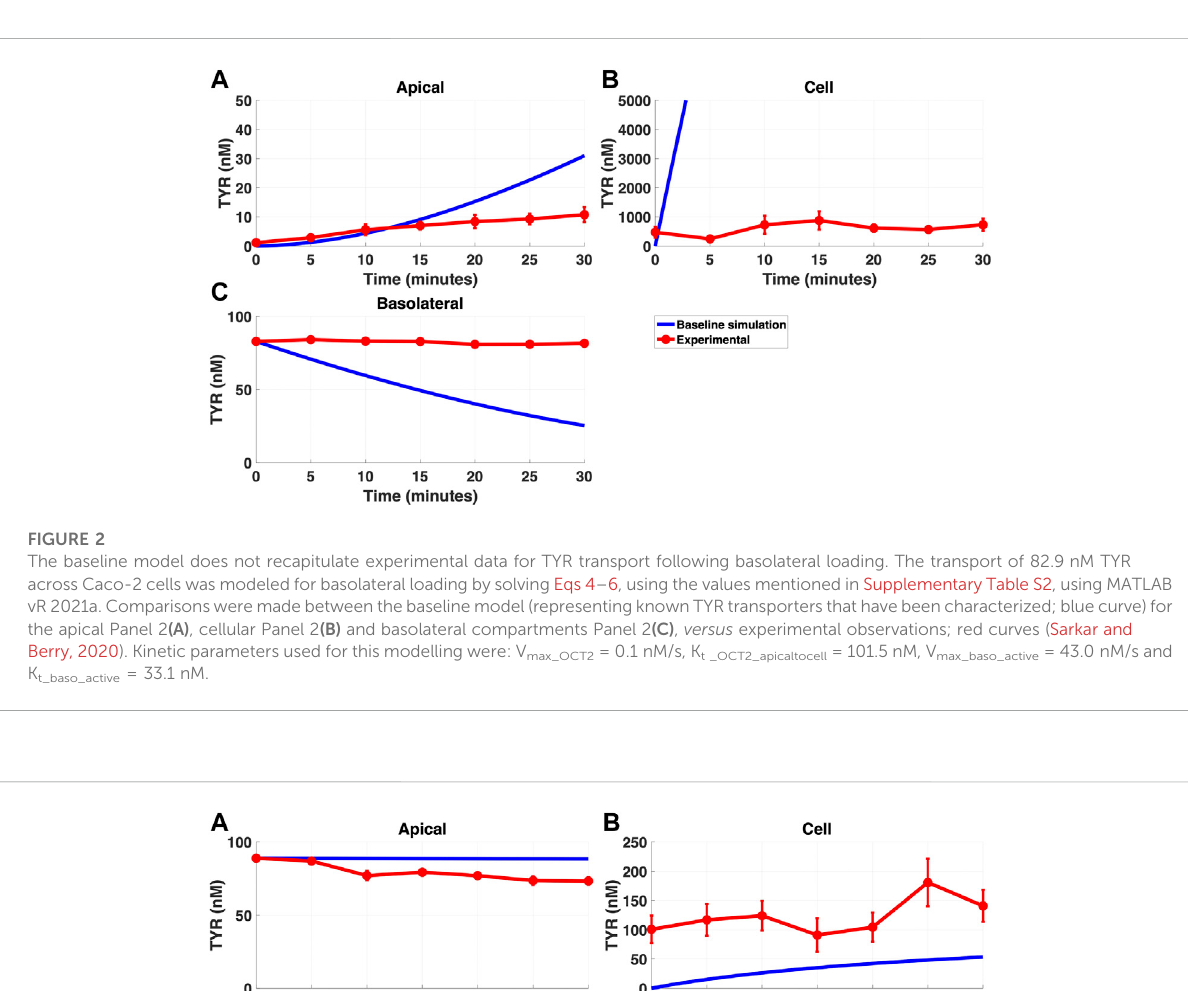
parameters and simpli fi ed choosing initial parameter value